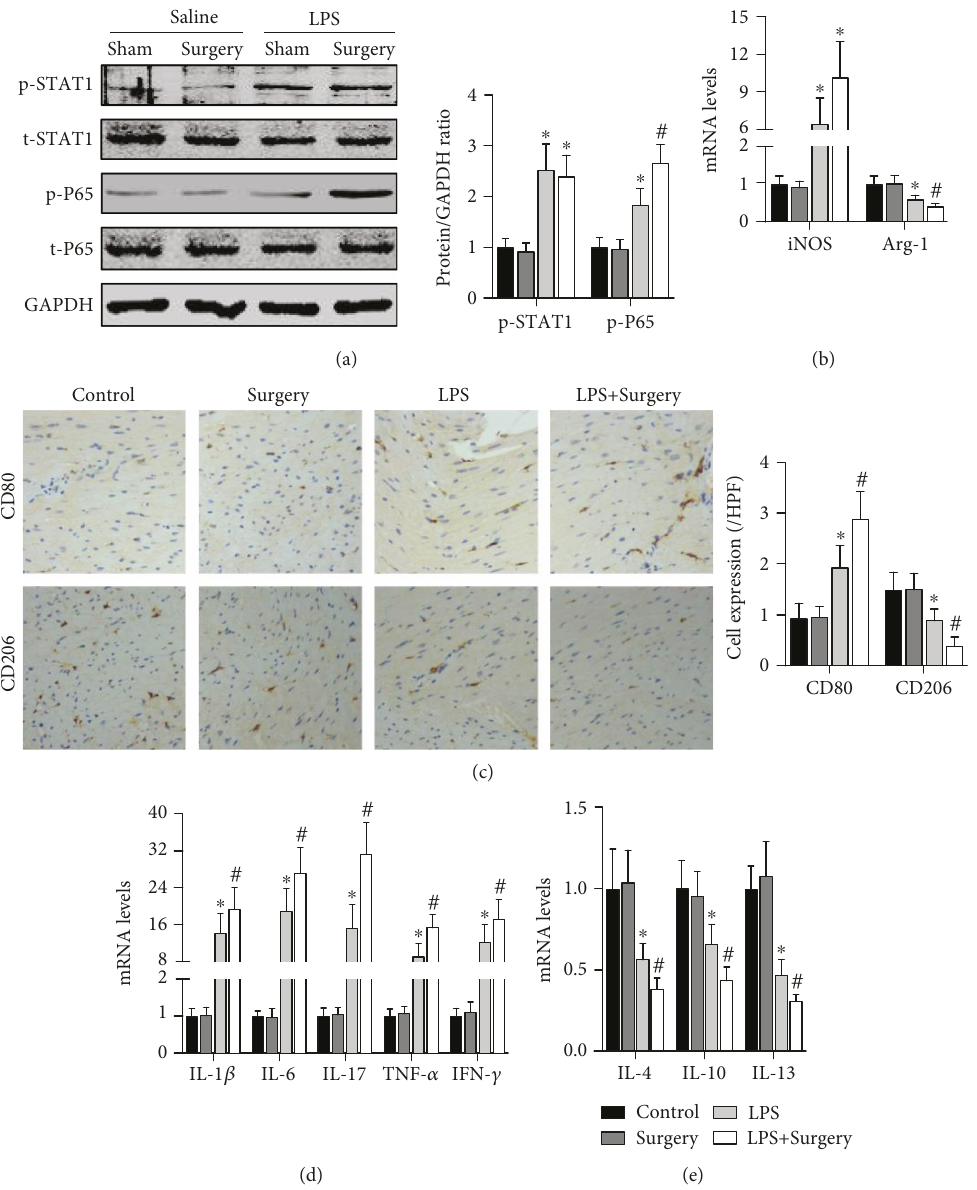
Figure 3: E ff ects of thyroidectomy on LPS-induced Mø di ff erentiation in mice. (a) STAT1 phosphorylation and p65 phosphorylation levels in the heart were measured. (b) The iNOS and Arg-1 mRNA levels in each heart sample were detected. (c) Heart CD80 and CD206 expression was analyzed by immunohistochemical staining (200x). (d and e) The iNOS, IL-1 β , IL-6, IL-17, TNF- α , IFN- γ , Arg-1, IL-4, IL-10, and IL-13 mRNA levels in the heart were detected. N = 5 in each group. ∗ P < 0 05 vs. the control group. # P < 0 05 vs. the LPS